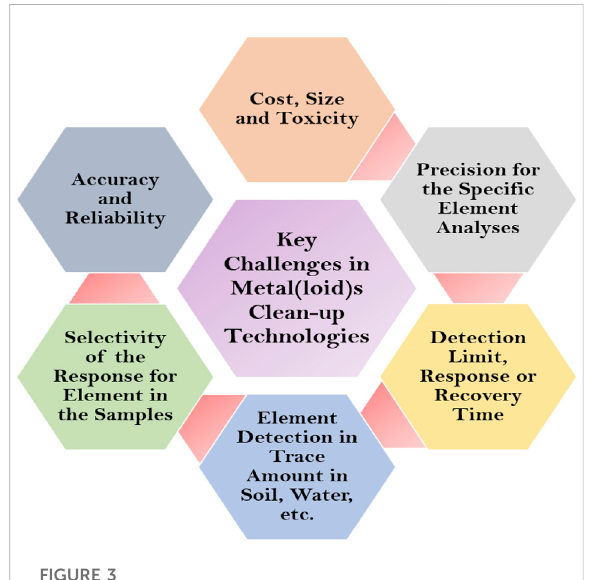
FIGURE 3 Key challenges to improve sustainable technologies for metal(loid)s detection and clean-up from the environment.